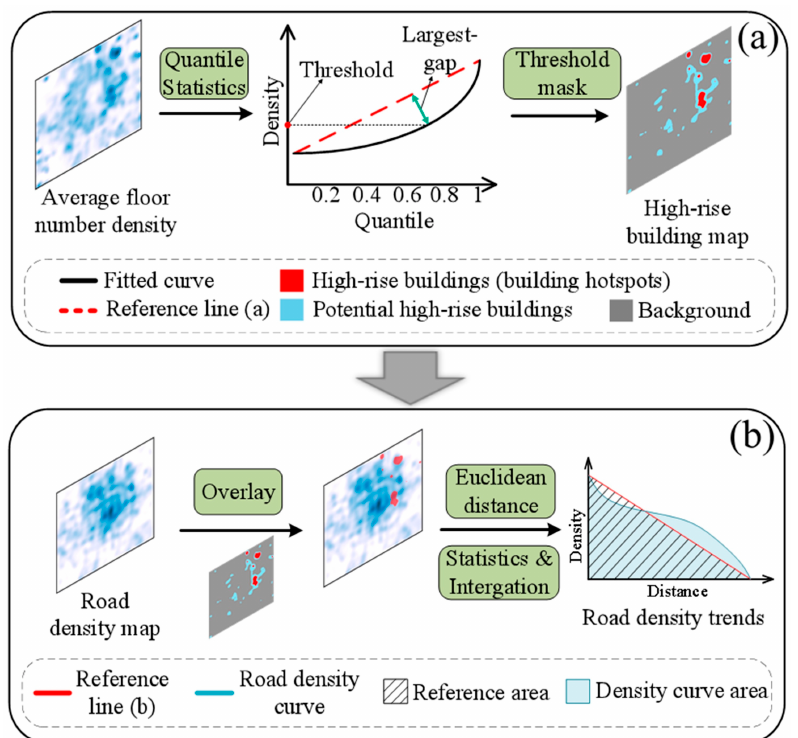
Figure 3. Illustration of the road distribution analysis. ( a ) Identify the high-rise buildings (building hotspots) using the quantile-based approach. ( b ) Analyze the road density pattern change from the city core to rural areas.